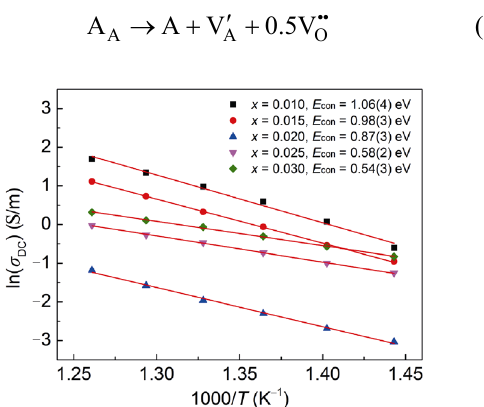
Fig. 11 Arrhenius plots of σ DC for (1 − x )KNN– x BZN ceramics with different BZN contents. The red lines show linear